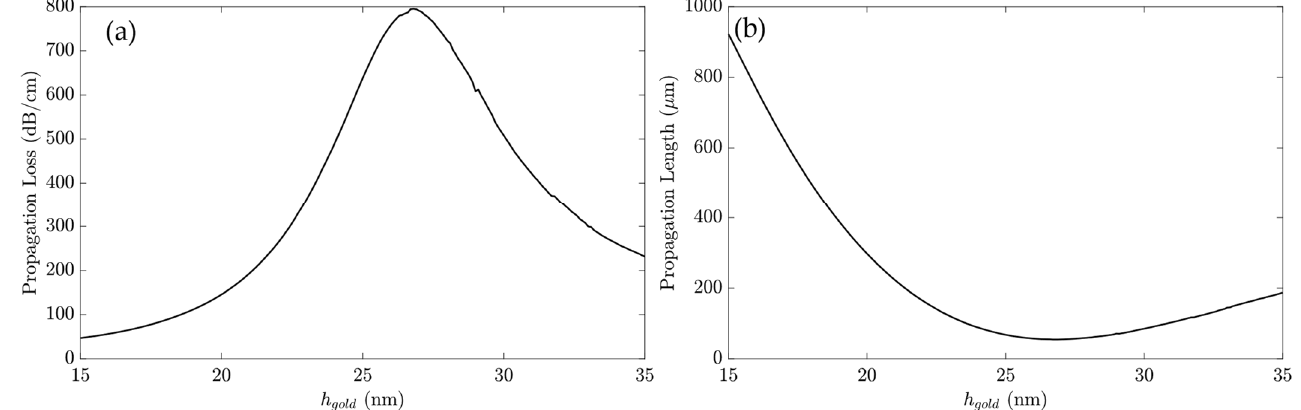
Figure 8. The Cytop layer h buffer 300 nm. ( a ) α versus h Au and ( b ) PL versus h Au .